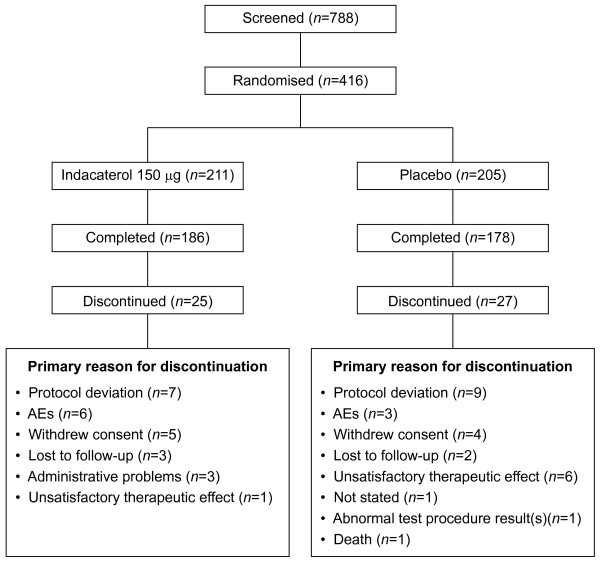
Patient disposition.